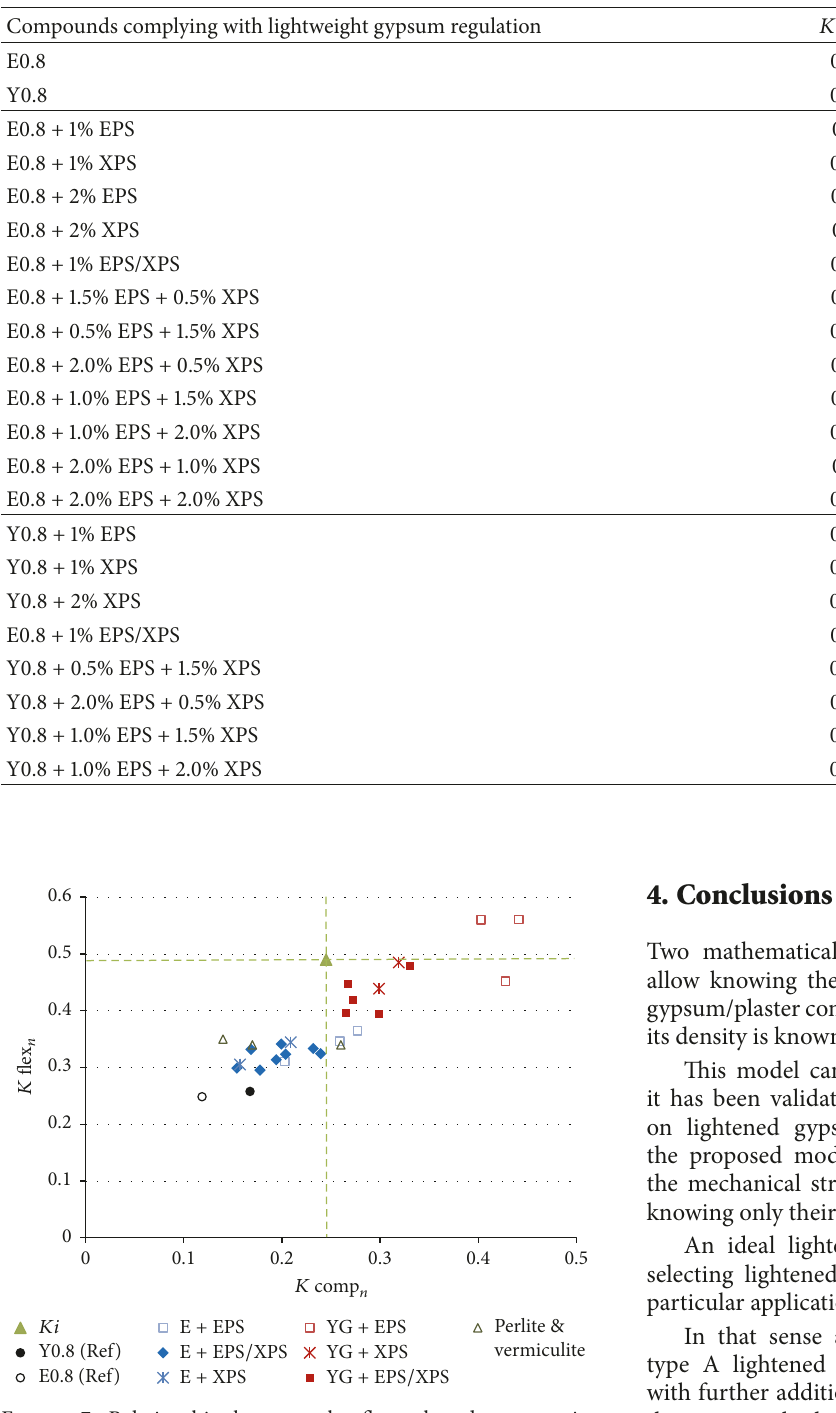
Figure 7: Relationship between the flexural and compression strength coefficients according to the type of waste